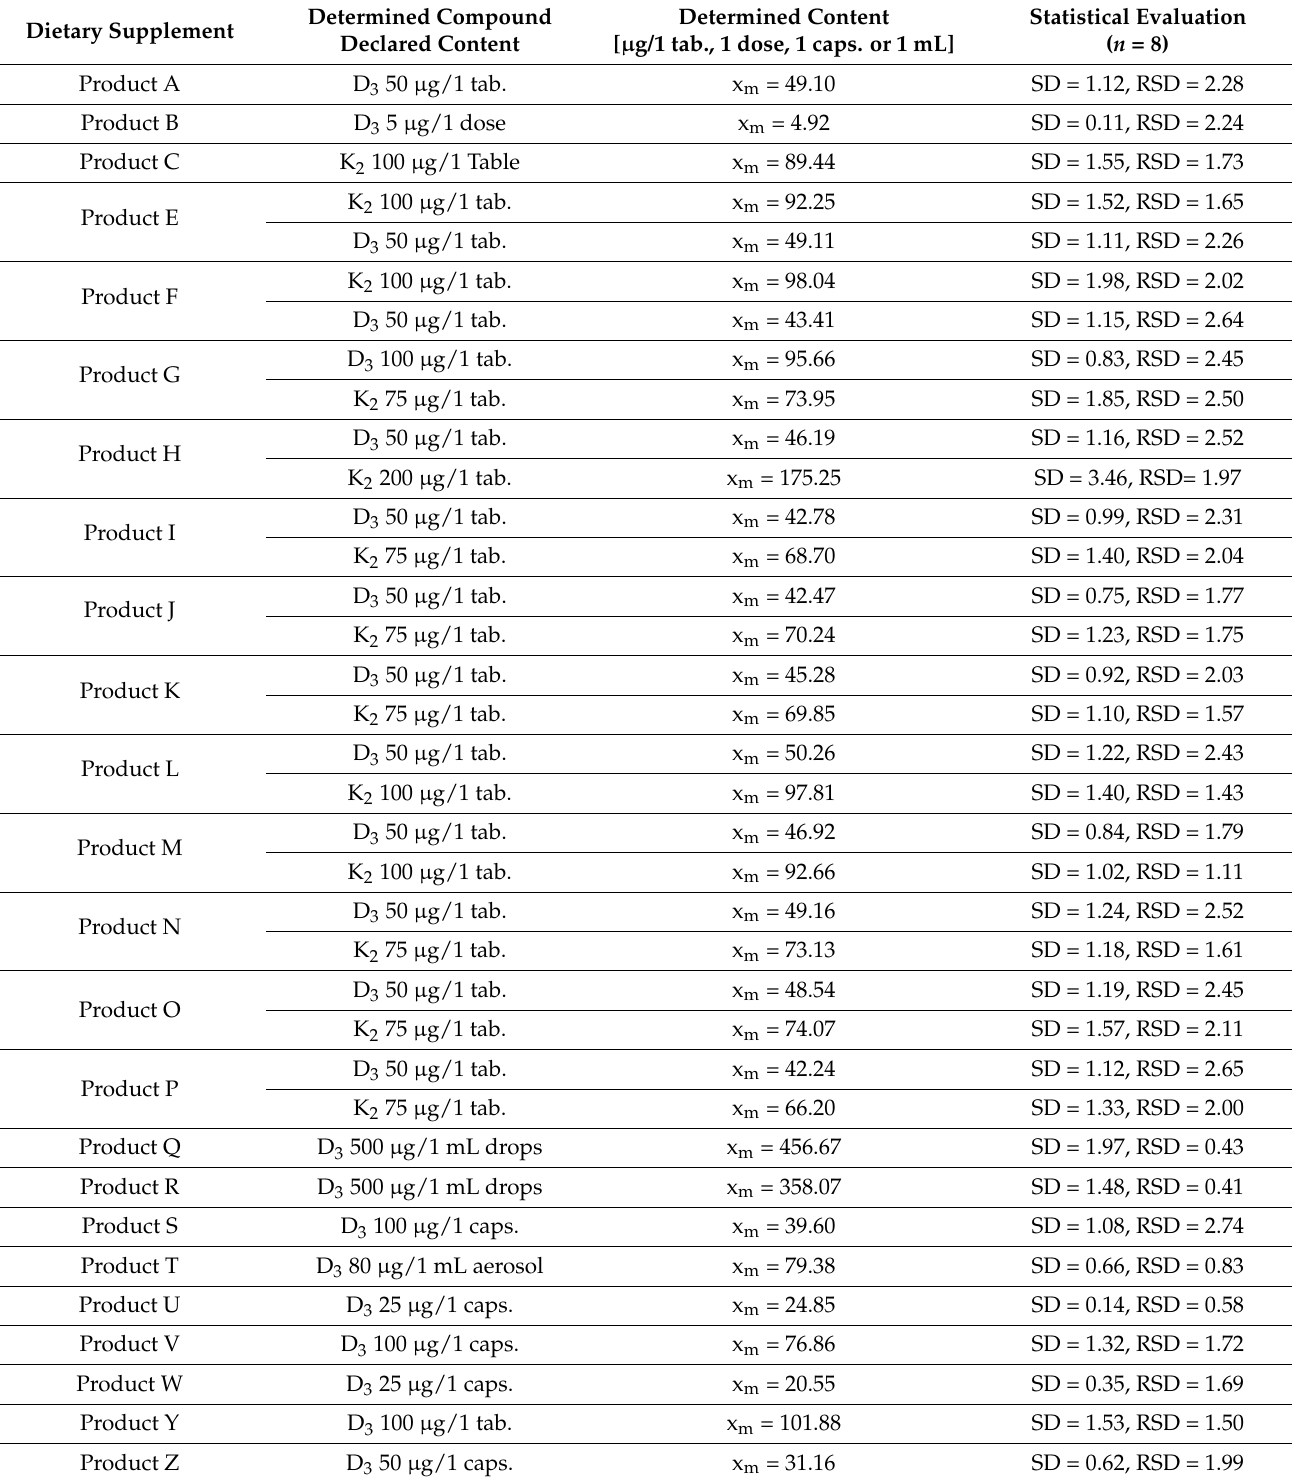
Table—tablet; caps.—capsule; x m —arithmetic mean; SD—standard deviation; RSD—relative standard deviation